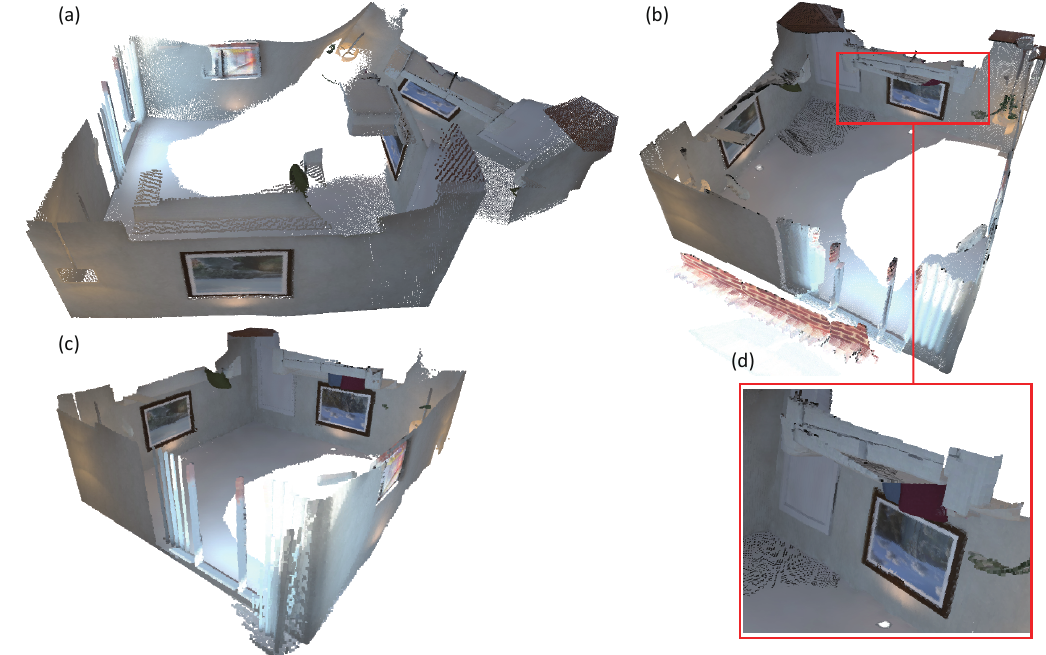
Figure 5. Reconstruction of the sequence kt3 in the ICL-NUIM benchmark [50]. ( a ) is produced by ElasticFusion [11,12]. ( b ) is produced by Kintinuous [36]. ( d ) gives details of the misaligned surfaces produced around the loop closure. ( c ) is produced by our